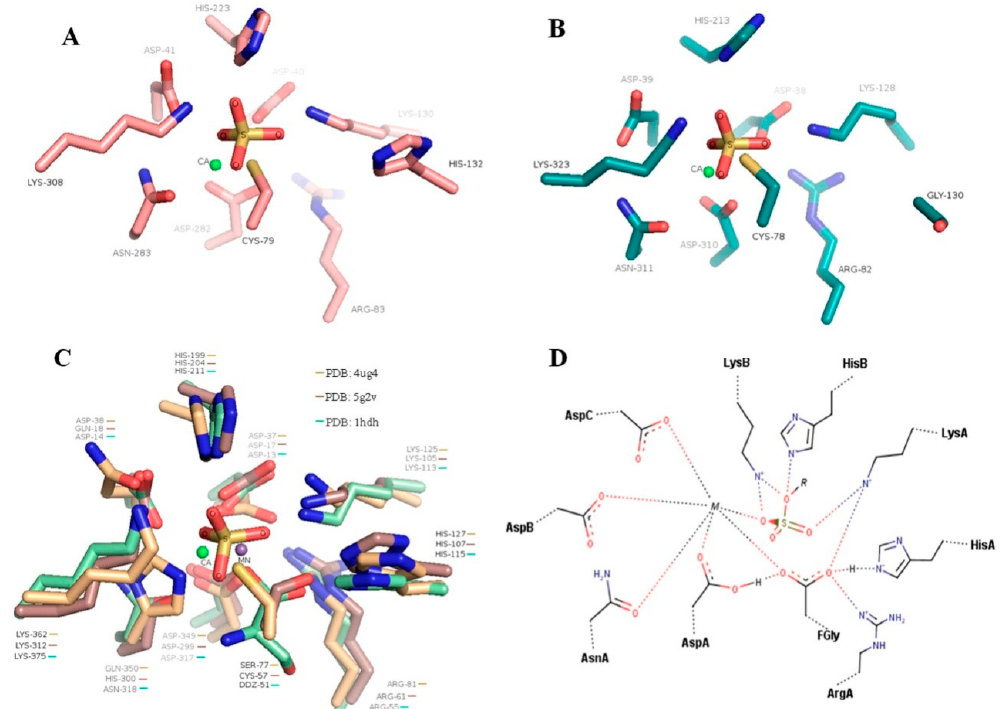
Figure 2. Location of amino acids in S -subsites of active sites region of homologous models of sulfatases SWF1 ( A ), SWF4 ( B ) and structural alignment of S -subsites of sulfatases from Bacteroides thetaiotaomicron BT4656, choline sulfatase from Sinorhizobium melliloti and arylsulfatase from Pseudomonas aeruginosa (protein data bank (PDB) entries: 5g2v, 4ug4, and 1hdh) ( C ). ( D ) Schematic arrangement of amino acids residues in sulfate-binding S -subsites of sulfatases which is proposed in [37]. The proposed function of the amino acid residues is shown in Table 1. Table 1. Structure ‐ based comparison of sulfate ‐ binding S ‐ subsites amino acid residues for several known sulfatases structures and fucoidan sulfatases SWF1 and SWF4.